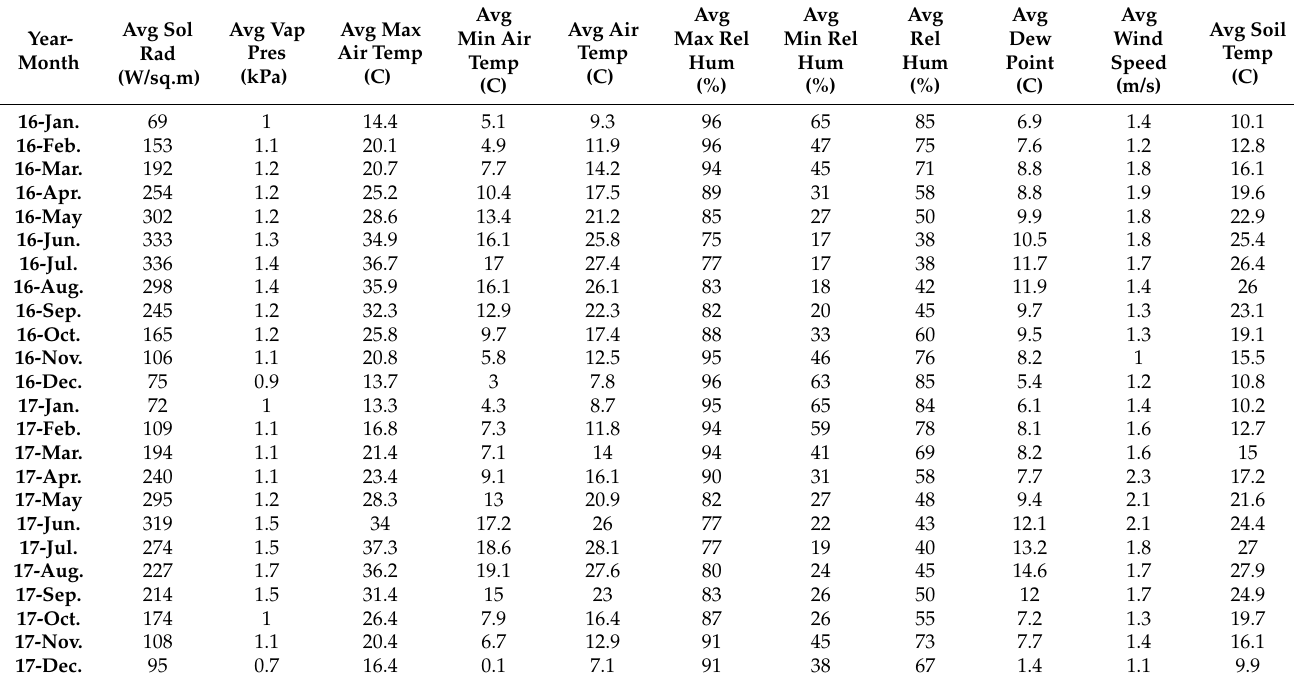
Table 1. Monthly average of different weather conditions of the experimental site (Parlier, CA, USA). Data obtained from CIMIS (https://cimis.water.ca.gov/ (accessed on 21 January 2022)).